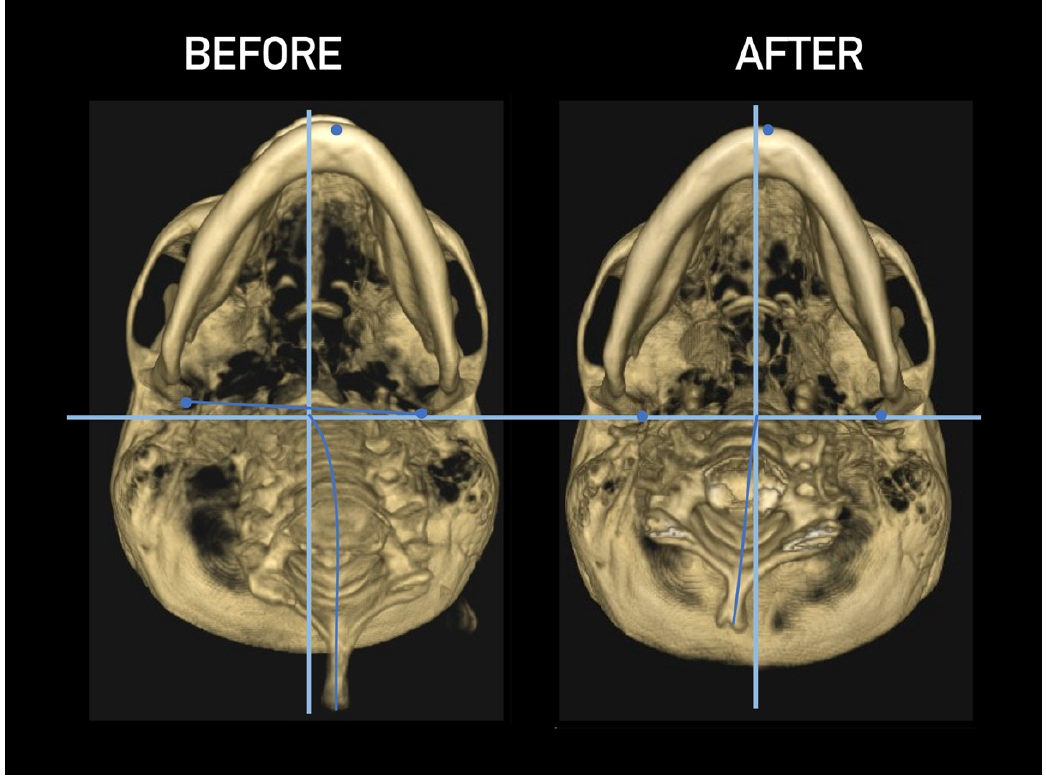
Figure 27. Effect of cervical vertebrae alignment. Inferior view.